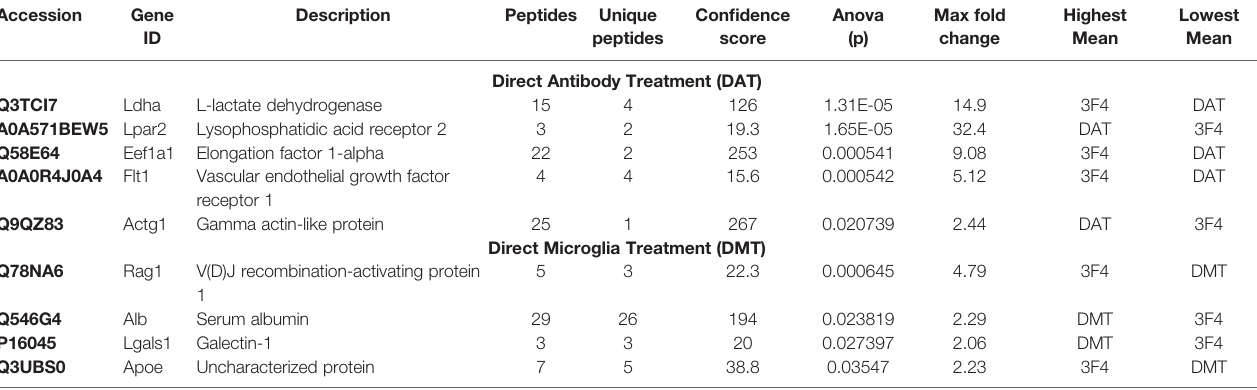
TABLE 6 | Properties of the identi fi ed allergenic proteins following direct antibody treatment (DAT) and direct microglia treatment (DMT) on the mouse primary neuron (MPN) cells in comparison with 3F4 antibody treated cells.